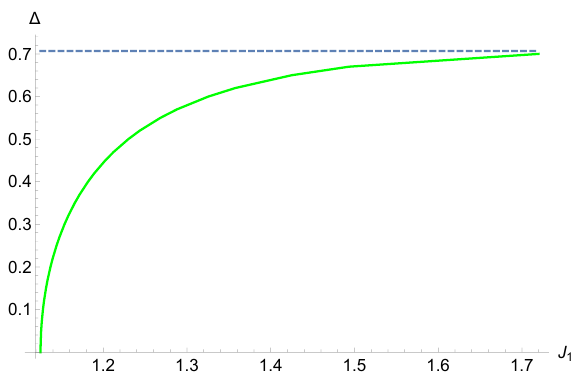
Figure 2 . Plot of the conjugate momentum J 1 for different values of the deformation parameter √ ∆ (all of them below the value ∆ = 1 / 2 ). Above the green line there is a giant graviton solution while below the green line there is only the point graviton